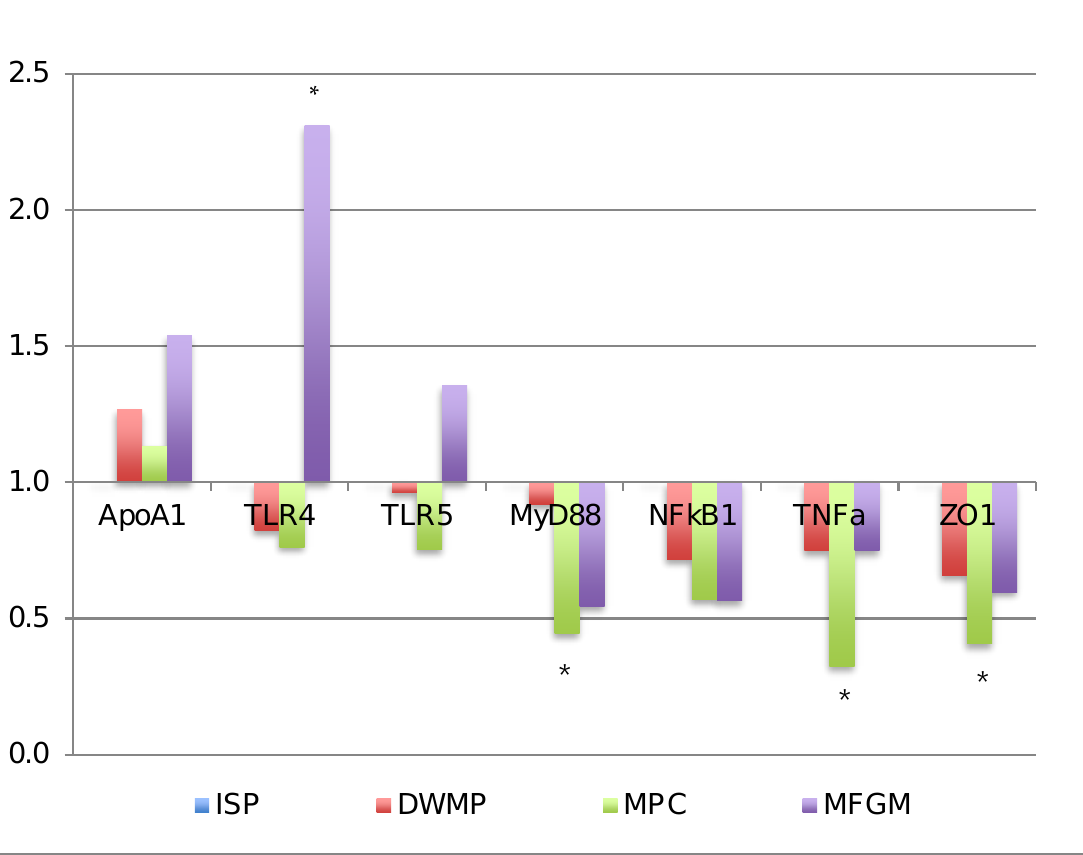
Figure 2. Intestinal gene expression: innate inflammatory markers. Gene expression data were from small intestines of n = 5/diet; fold increases were considered significant if at least 2-fold different from the ISP comparator and are denoted by the use of “*” TLR4 was increased 2.3-fold in MFGM compared to ISP; however, downstream responses ( NFkB and TNFa ) were modestly downregulated. Tight Junction Protein ( ZO-1 ) was downregulated 2.4-fold in MPC compared to ISP.